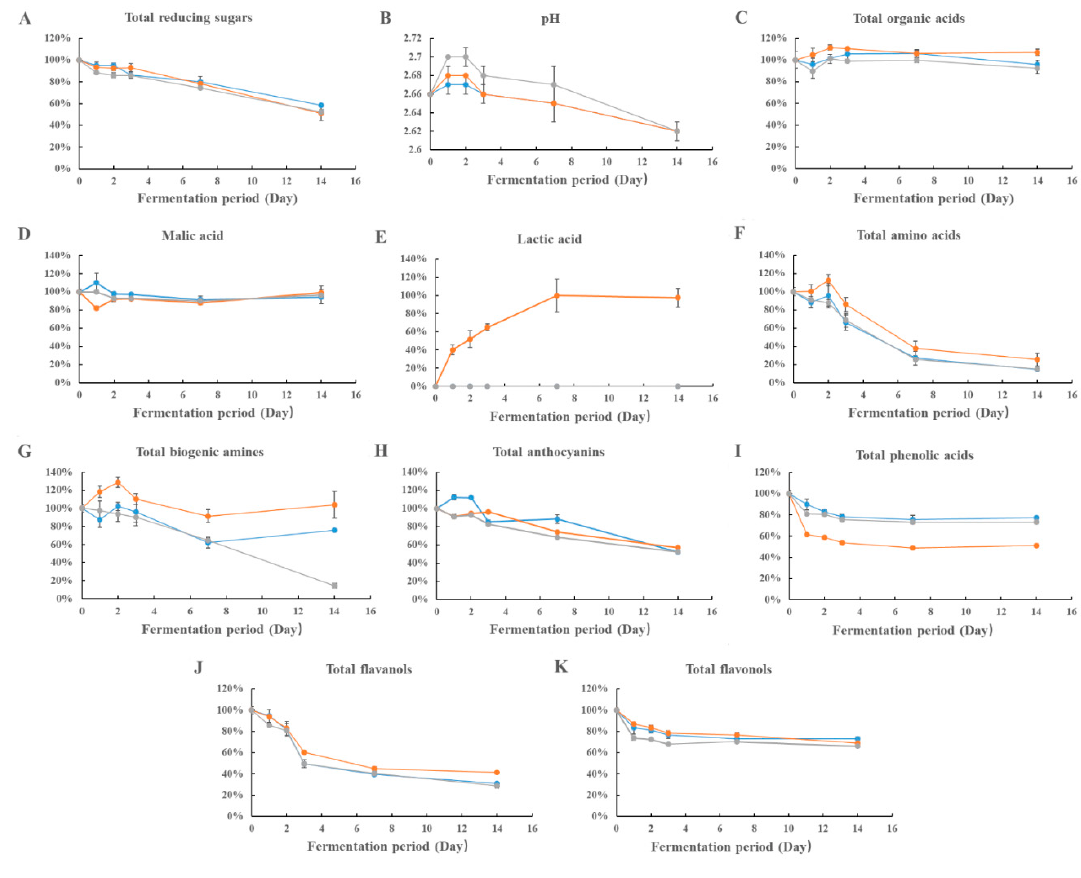
Figure 3. Primary and secondary nutrients in bog bilberry juice in 14 days. “ ”, “ ” and “ ” represent the growth pattern of Lactobacillus brevis , Lactobacillus acidophilus , and Oenococcus oeni , respectively. The data are the mean ± standard deviation of triplicate tests.